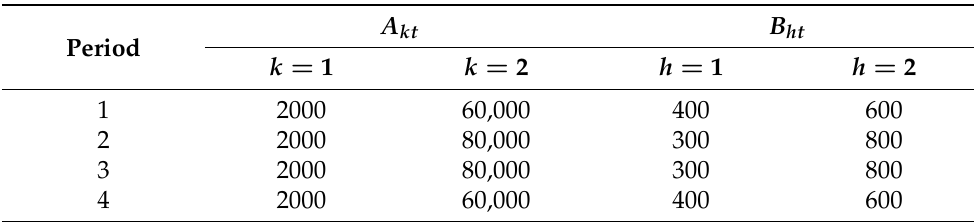
Table 3. Parameter settings of A kt and B ht